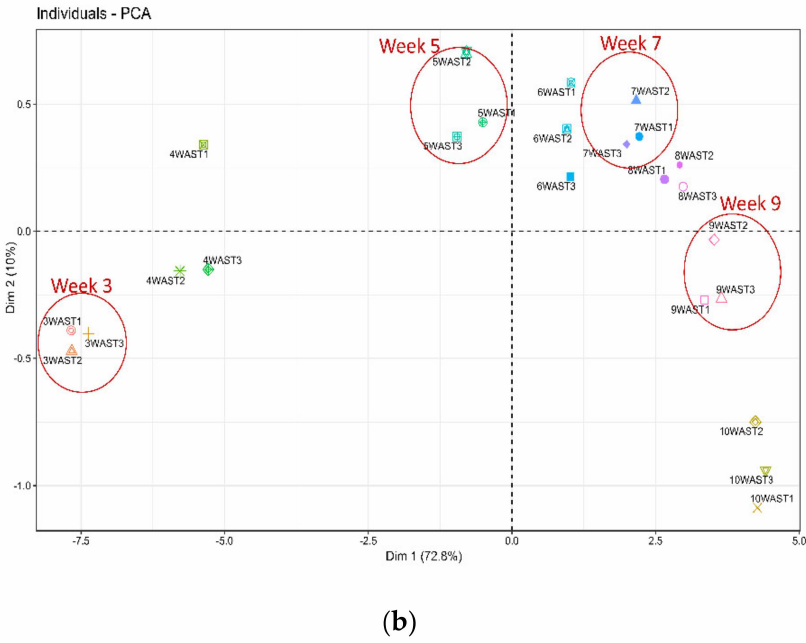
Figure 1. ( a ) Principal component analysis of the effects of salinity levels and 24-epibrassinolide on EC se ; ( b ) principal component analysis on separation of soil extracts based on weeks after commence- ment of irrigation with saline water (WAST). SL 0 —0.11 dS/m; SL 1 —3.24 dS/m; SL 2 —6.06 dS/m; SL 3 —8.63 dS/m; BR—growth stages of 24-epibrassinolide application; BR 0 —control (no BR ap-